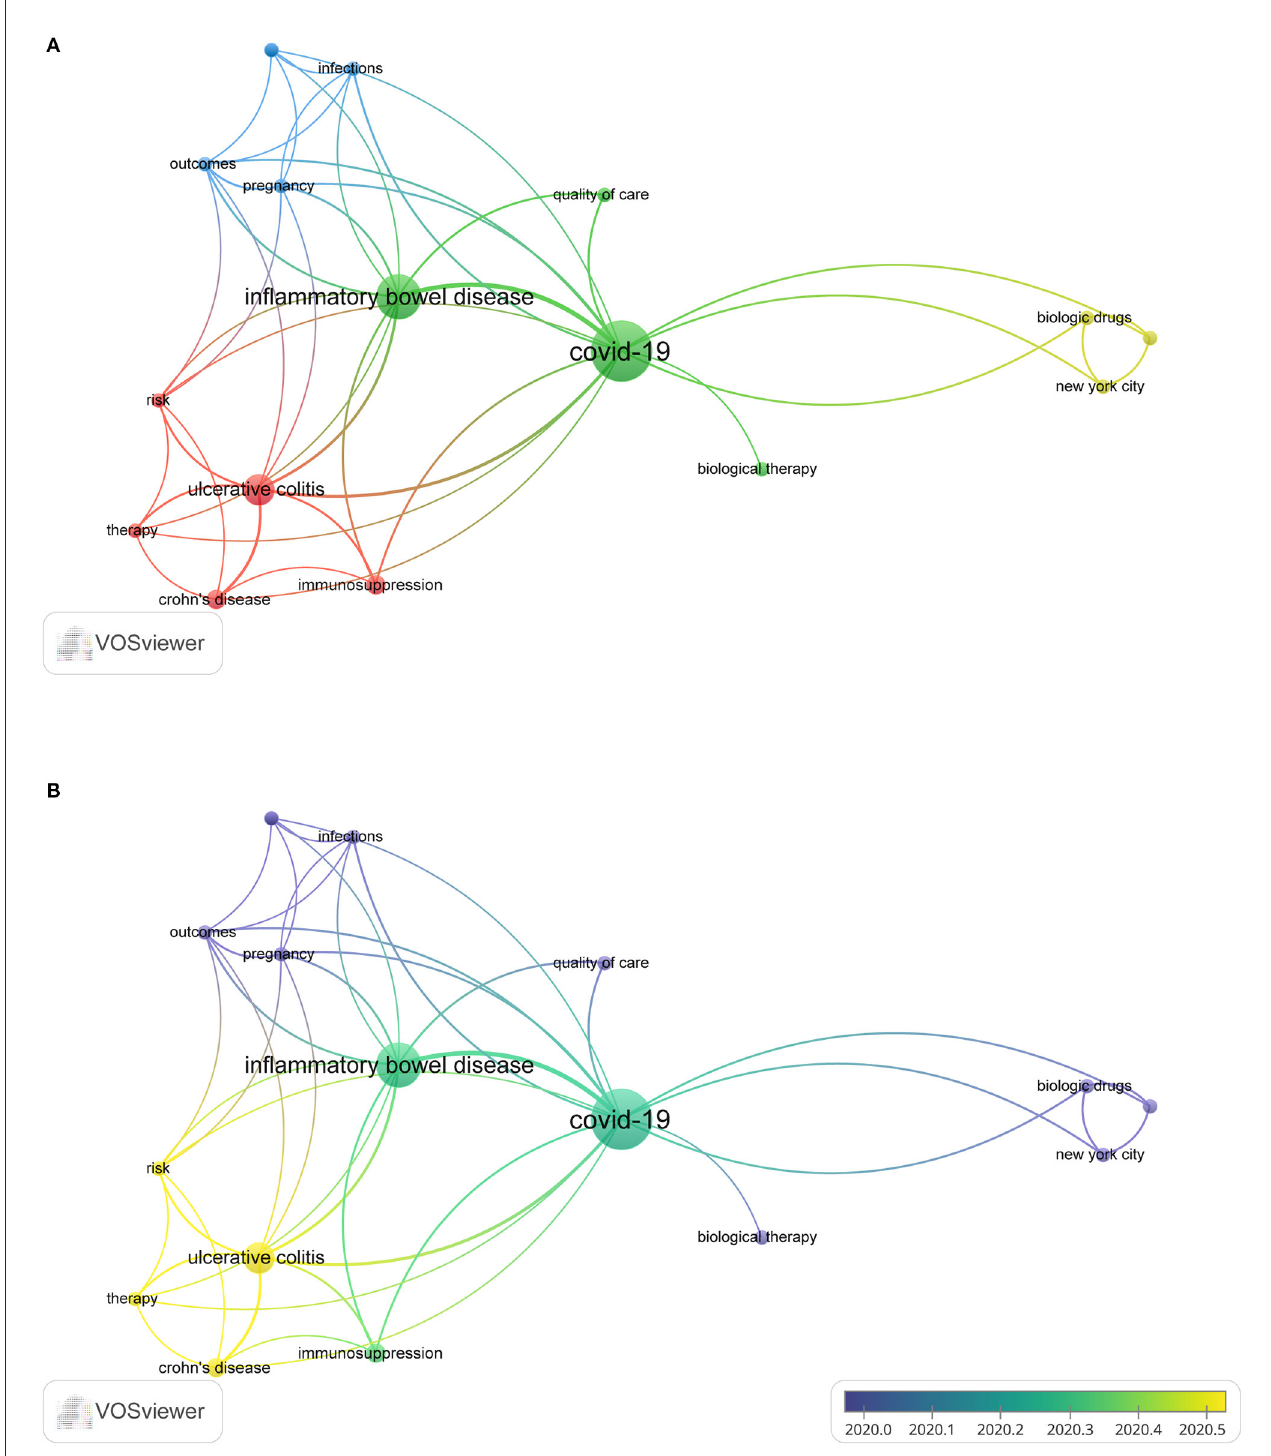
FIGURE7 The co-occurrence of keywords (A) and time sequence chart of keywords (B) of the literature on the management of COVID-19 on IBD patients.